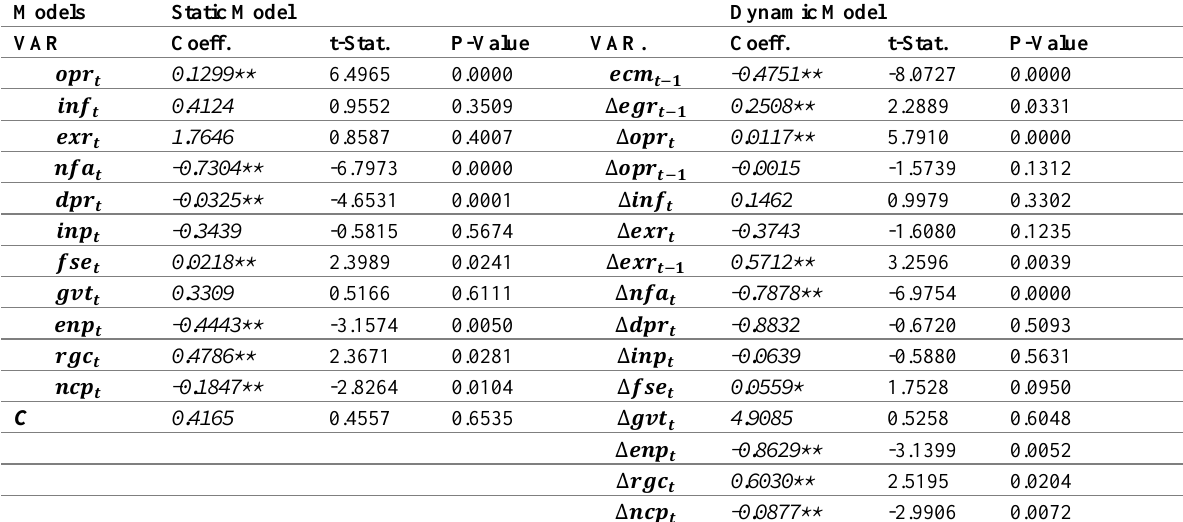
Table 4: Estimated Coefficients for Static and Dynamic Models